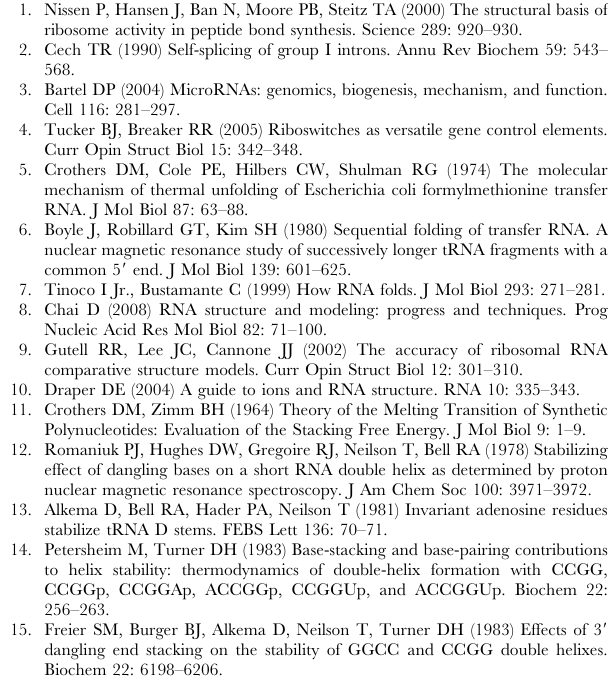
Table S1 End-stacking of canonical helices in various RNA crystal structures. Table S2 Identity of helix-ending basepairs and its influence on helix capping direction.